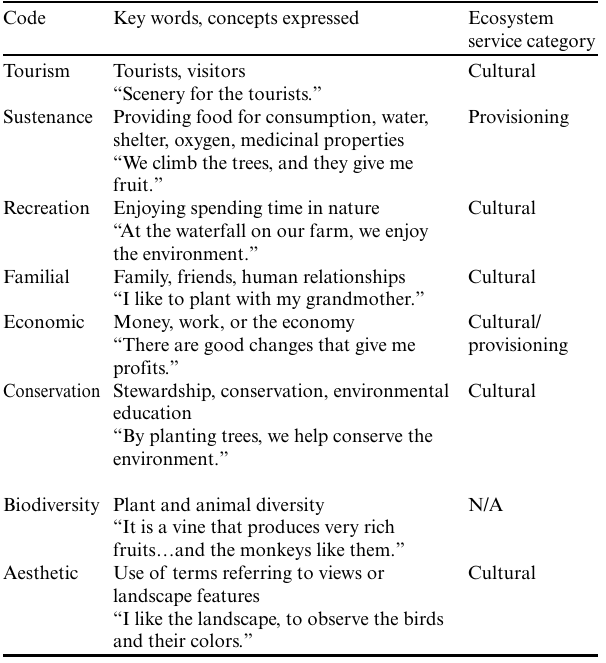
Table 3. Environmental values identified from photovoice workshops (prompt 1). The ecosystem service categories are derived from the Millenium Ecosystem Assessment (2003).